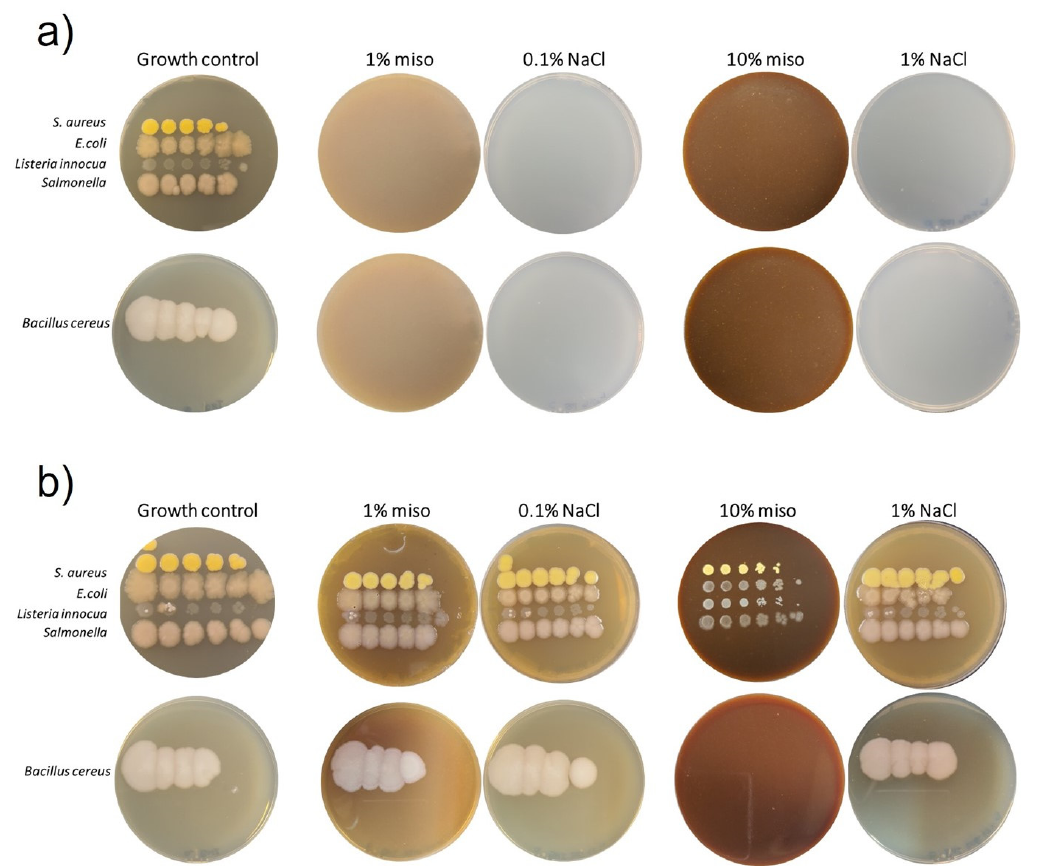
Figure 1. Plates resulting from in vitro antimicrobial activity determination for pathogenic microor- ganisms, incubated for 7 days (stationary phase) at adequate temperatures. Growth positive control plates in BHI medium are also shown. From left to right, drops from 10 − 1 to 10 − 5 dilutions. Miso concentrations of 1.0 and 10.0% ( w / w ). Sodium chloride agar plates with the concentration of salt equivalent to each miso plate. ( a ) Results for preliminary test, Test I, with no nutritive media, only different miso concentrations as substrate. ( b ) Results for Test II, with nutritive media and different miso concentrations.